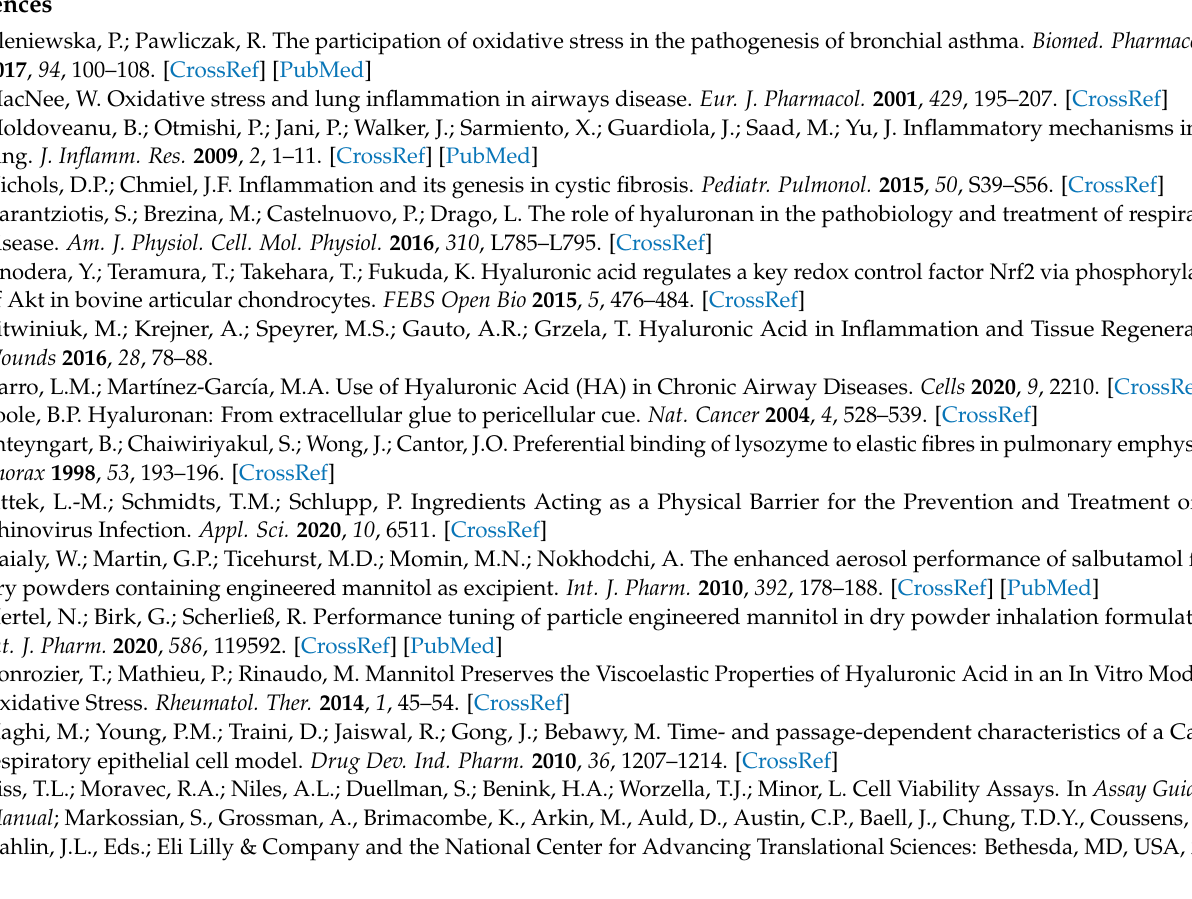
tary Figure S4: SEM Images of PolmonYDEFENCE/DYFESA and Sodium Hyaluronate (Na-Hya) at 100 ×